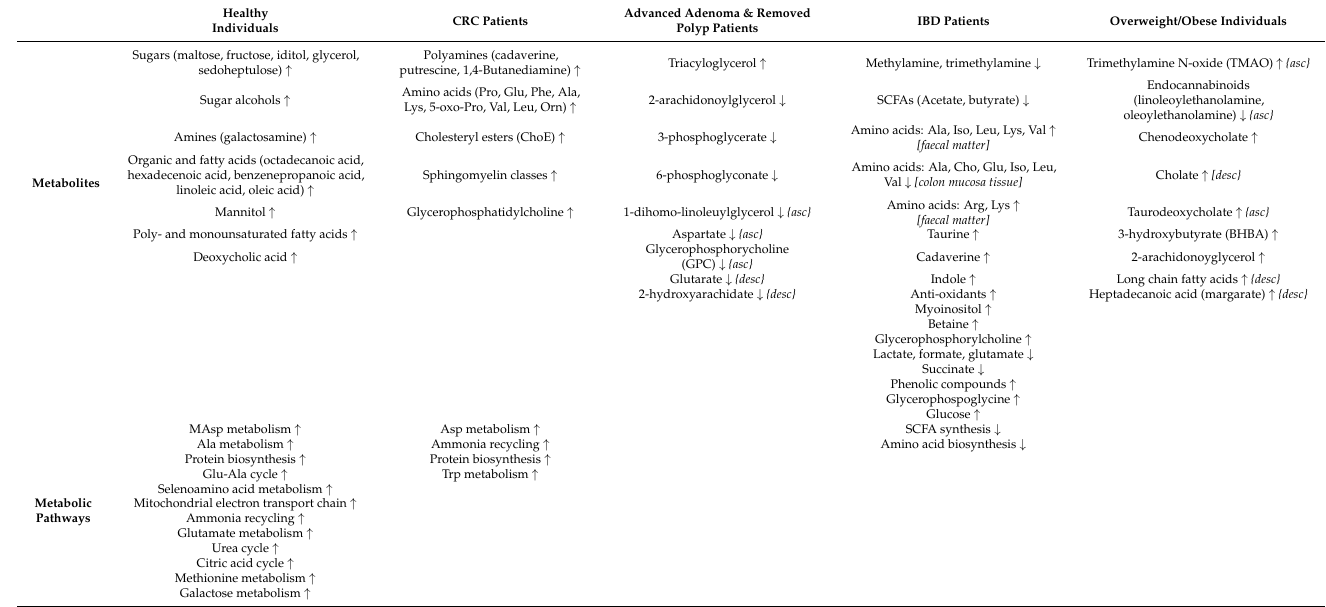
Table 3. Variations in metabolites found in faecal matter or ascending/descending colon biopsies between healthy and CRC patients or patients with advanced adenomas and removed polyps, or IBD patients or adults with increased BMI (overweight and obese individuals) [83–85,124,136,137]. [ ↑ ]: increased abundance, [ ↓ ]: decreased abundance, {asc}: ascending/right colon, {desc}: descing/ left colon.